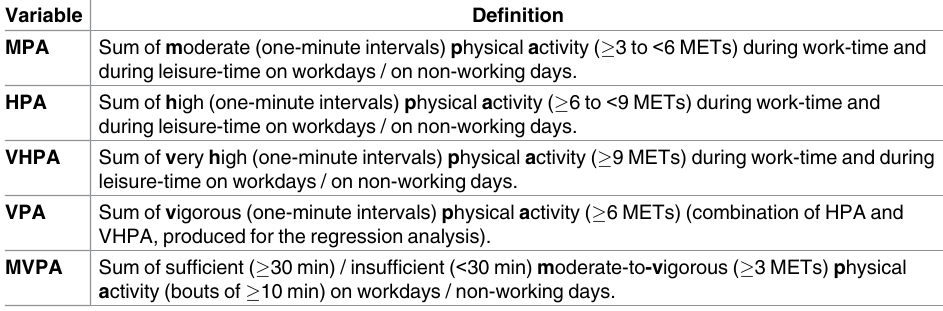
Table 1. List of SenseWear physical activity variables and their definition.